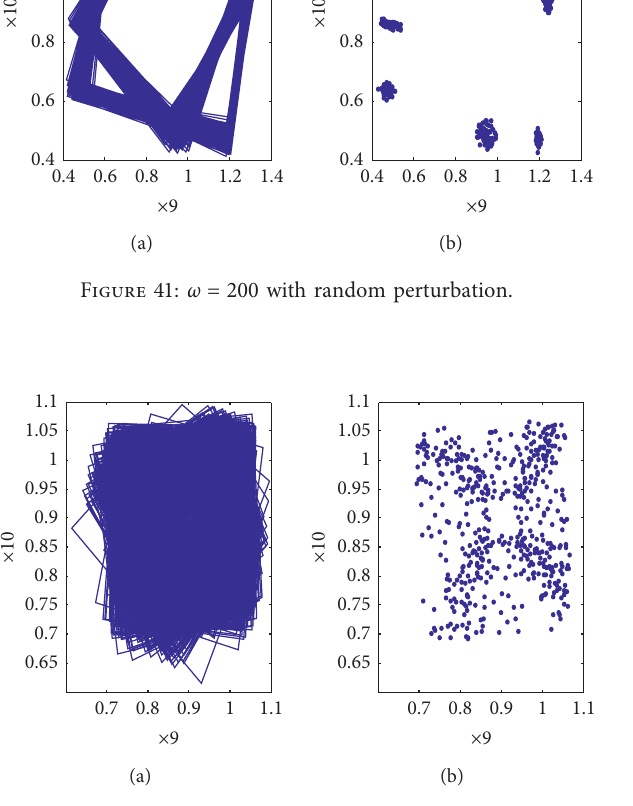
Figure 42: ω � 232 with random perturbation.